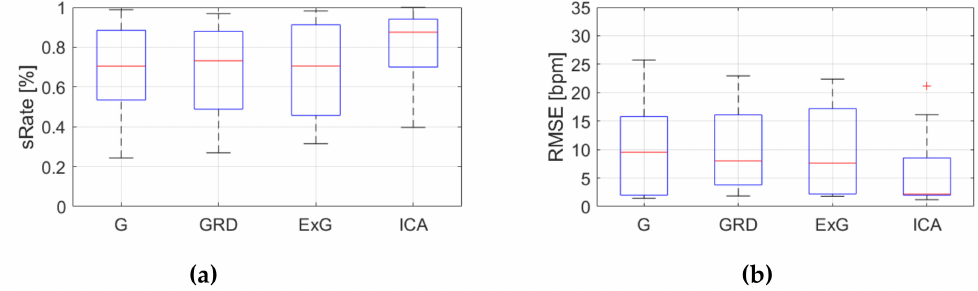
Figure 9. Comparison of signal extraction methods, algorithm No.1 (PSD), part 1: ( a ) box plots for sRate ; ( b ) box plots for RMSE . Blue lines—IQR range, red line—median